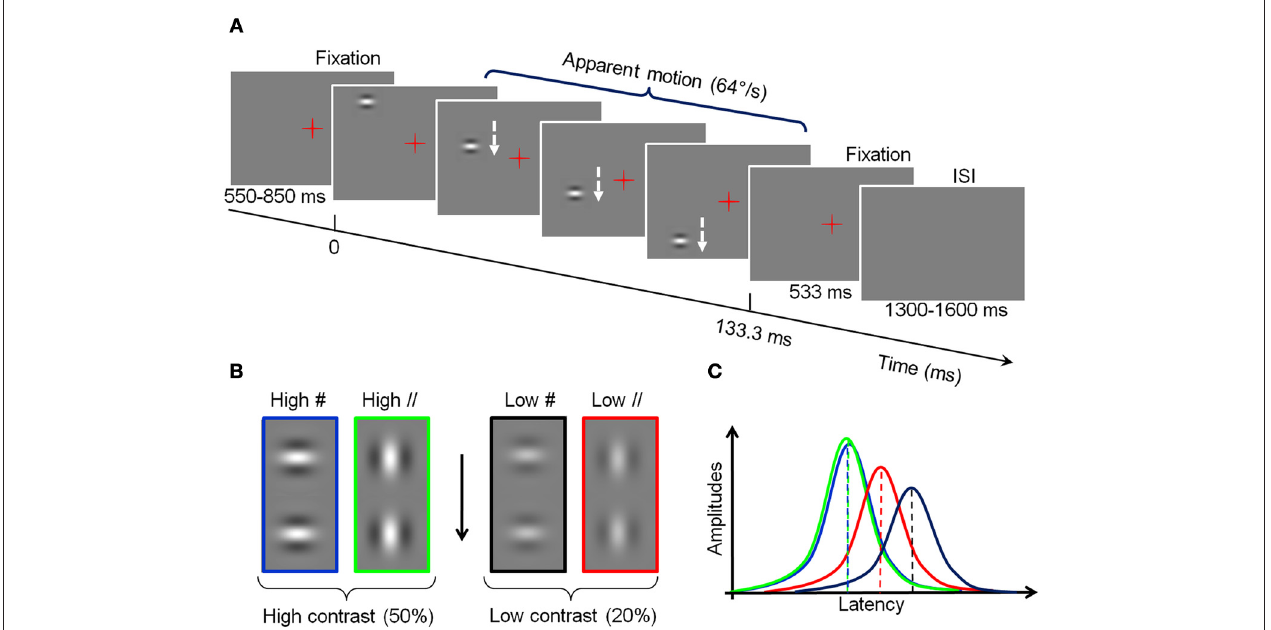
FIGURE 2 | Experimental design and hypotheses. (A) Timing of a trial. A Gabor patch is presented sequentially in different positions along a vertical axis, left or right from fixation (B) High and low-contrast Gabor at two orientations used in the experiment. For visualization purpose, the contrasts of the figure do not correspond to the real ones. (C) Schematic